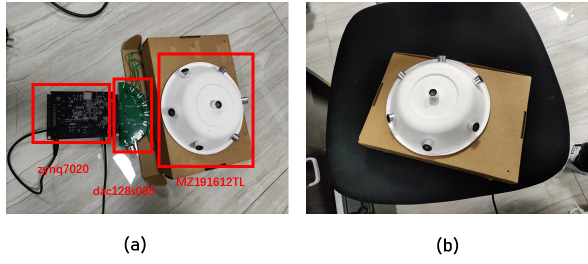
Figure 3. (a)Internal circuit of the base station. (b) Outside of the base station.